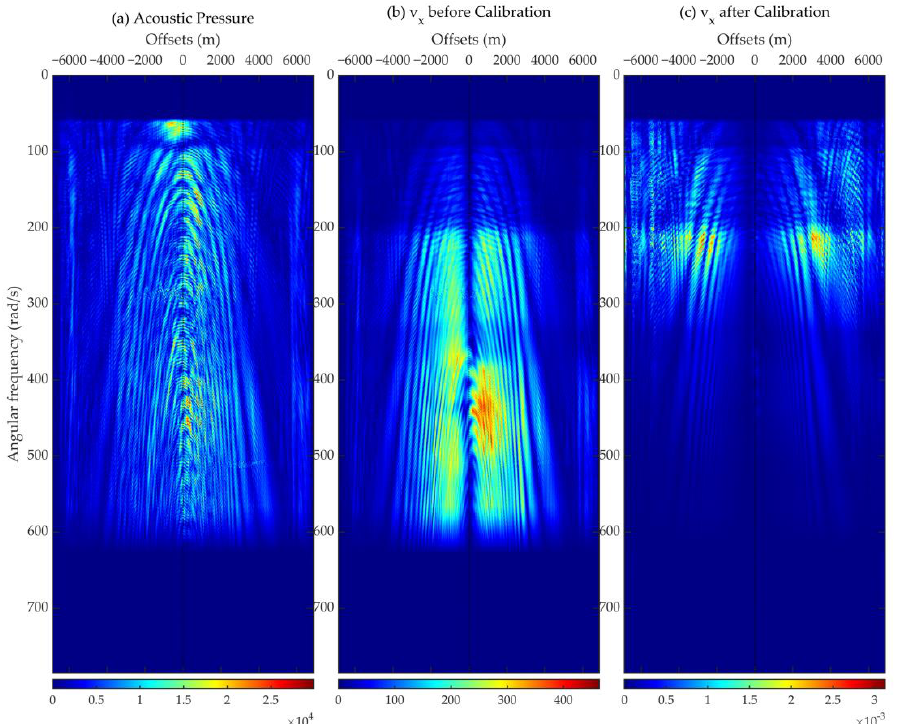
Figure 13. Comparison of the ( a ) acoustic pressure component, and horizontal particle velocity component ( b ) before and ( c ) after calibration, in the ω - x domain.